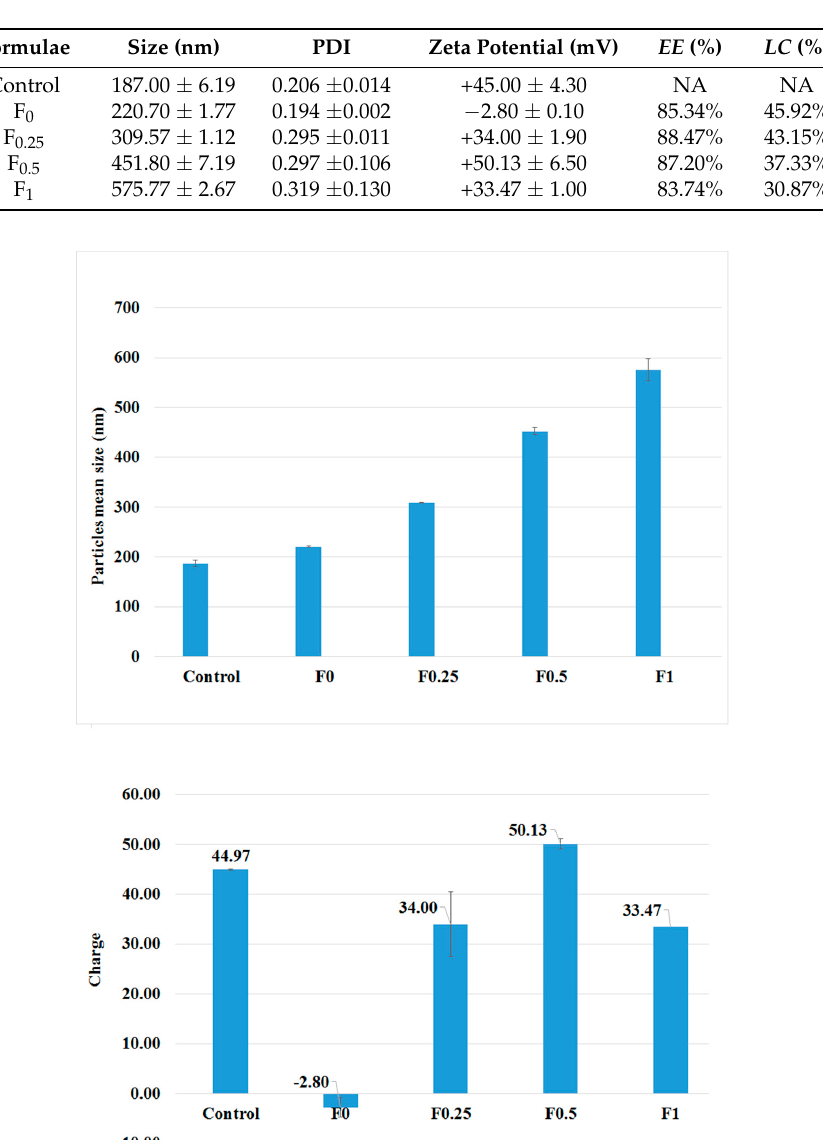
Figure 1. The particles’ mean sizes ( top ) and the surface charge profiles ( down ) of PLGA and LMWC- PLGA NPs with different concentrations of